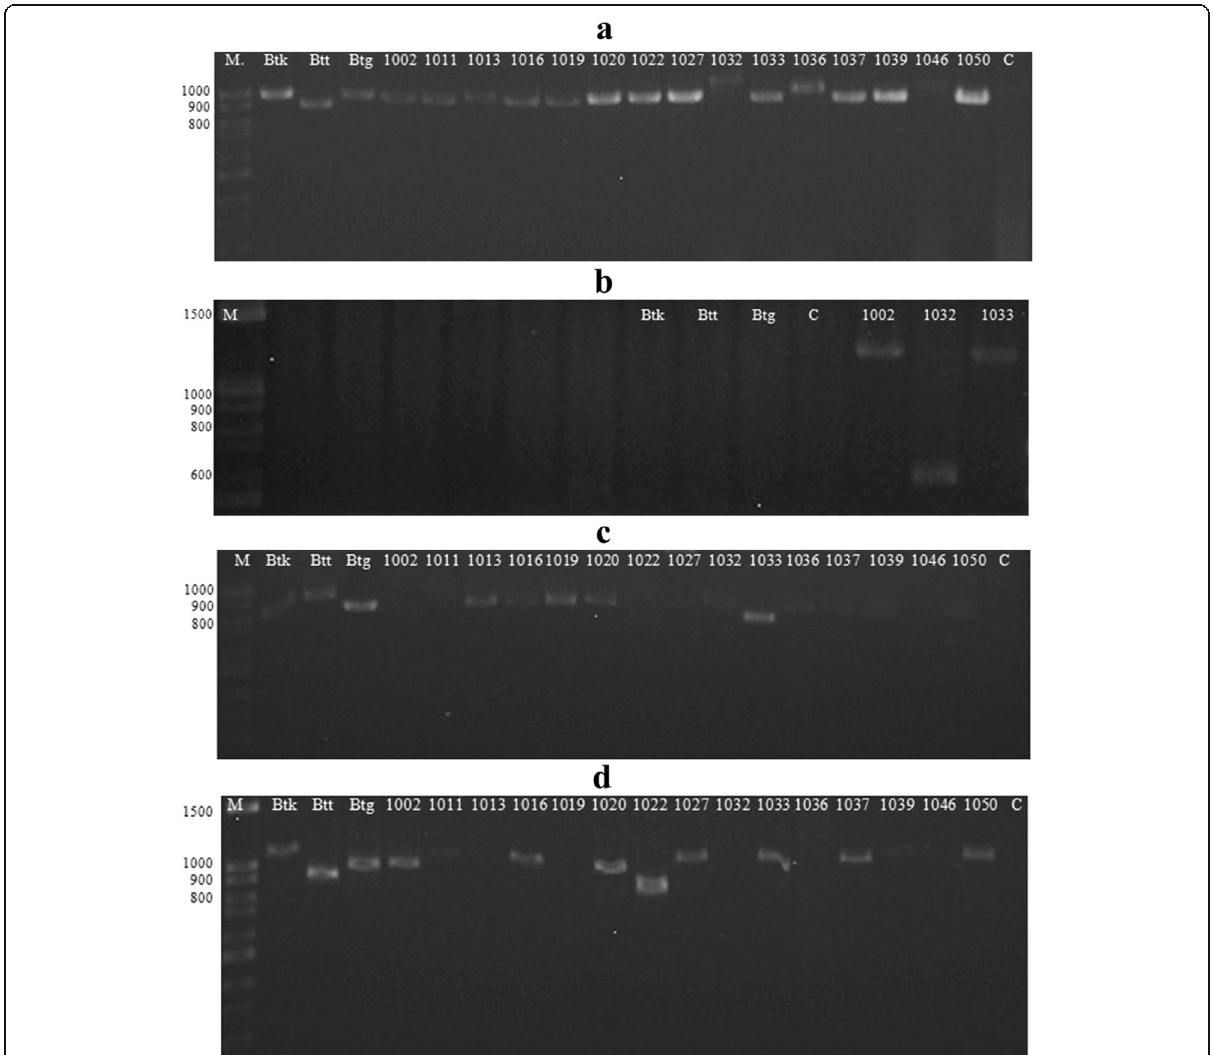
Fig. 3 Agarose gel (1%) electrophoresis of PCR products obtained from the Iranian Bacillus thuringiensis strains. a With Lep2, b Spcry1Aa, c St2C, d UNcry2 primer pairs; reference strains: Bt kurstaki , Bt thuringiensis, and Bt galleriae ; C , negative control; M , Marker (100